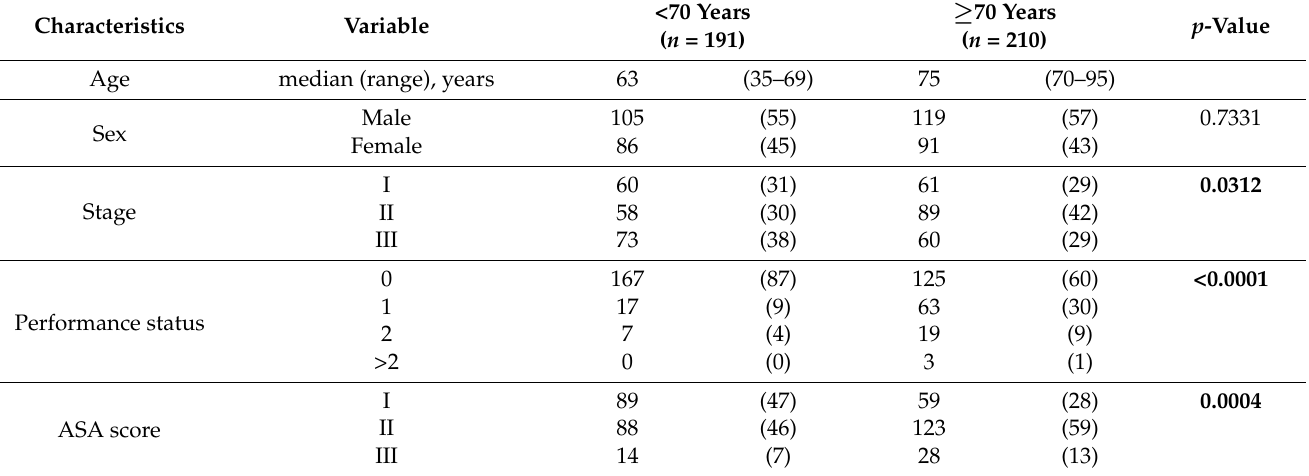
Table 1. Patient characteristics, n (%)